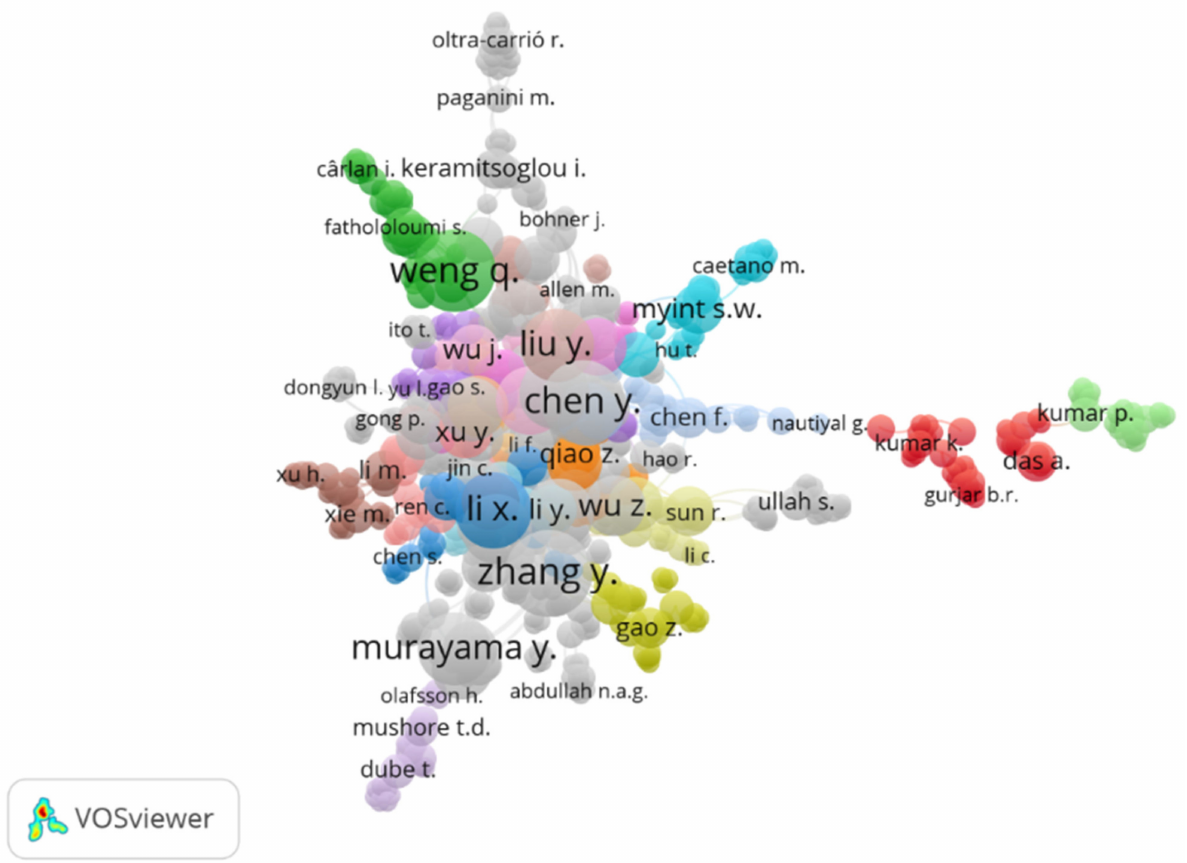
Figure 8. Interrelationships of authors in publications. The diameter of the circle corresponds to the number of published articles, with the authors Zhang Y., Chen Y., and Weng Q. standing out, with 18, 17, and 16 articles,